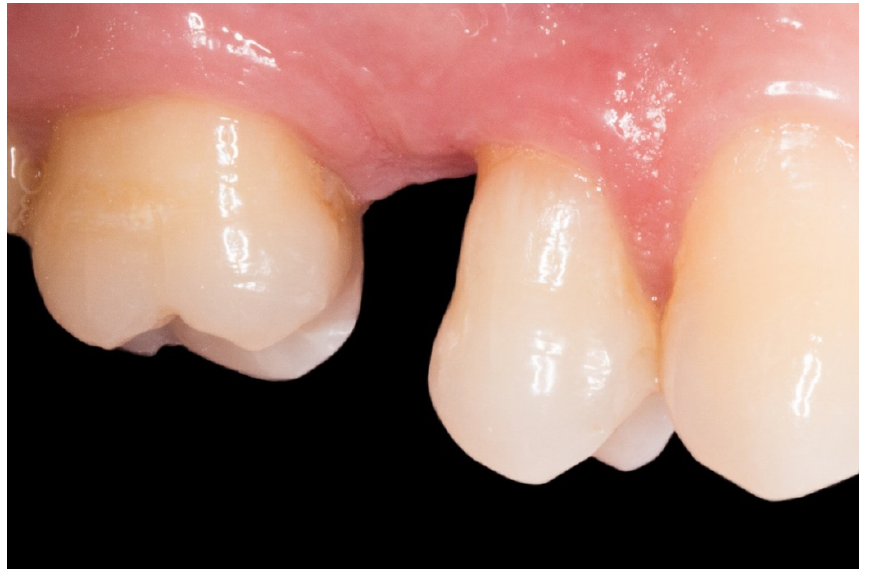
Figure 1. A posterior maxilla edentulous space.